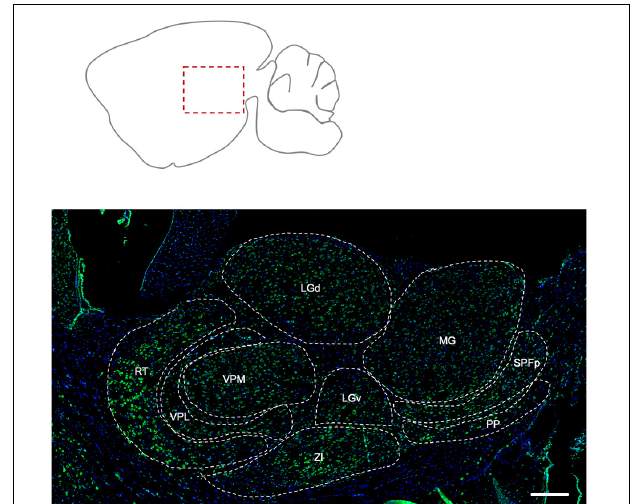
FIGURE 4 | Distribution of Elovl5 in thalamus. Elovl5 (green) expression in the thalamus has a region-specific intensity. The most intense labeling is shown by the reticular nucleus. LGd, dorsal part of lateral geniculate complex; LGv, ventral part of lateral geniculate complex; MG, medial geniculate complex; SPFp, subparafasciular nucleus, parvicellular part; PP, peripeduncular nucleus; ZI, zona incerta; VPM, Ventral posteromedial nucleus of thalamus; VPL, Ventral posterolateral nucleus of thalamus; RT, Reticular nucleus of thalamus. Scale bar: 200 µ